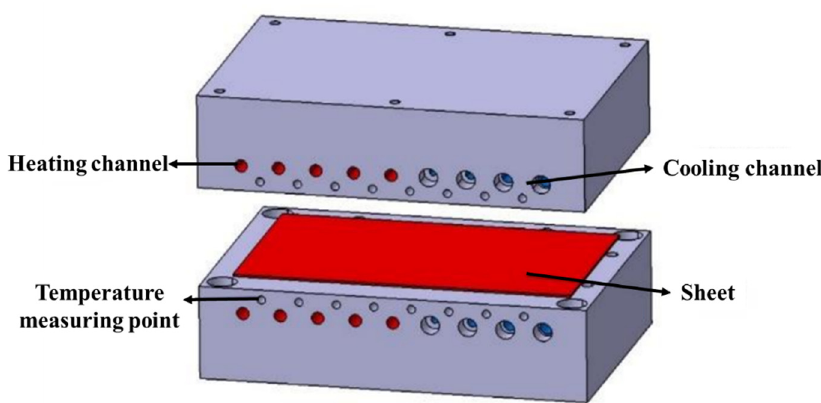
Figure 4. Schematic of the temperature-control die. Table 2. Experiment scheme of BR1500HS in the hot stamping.